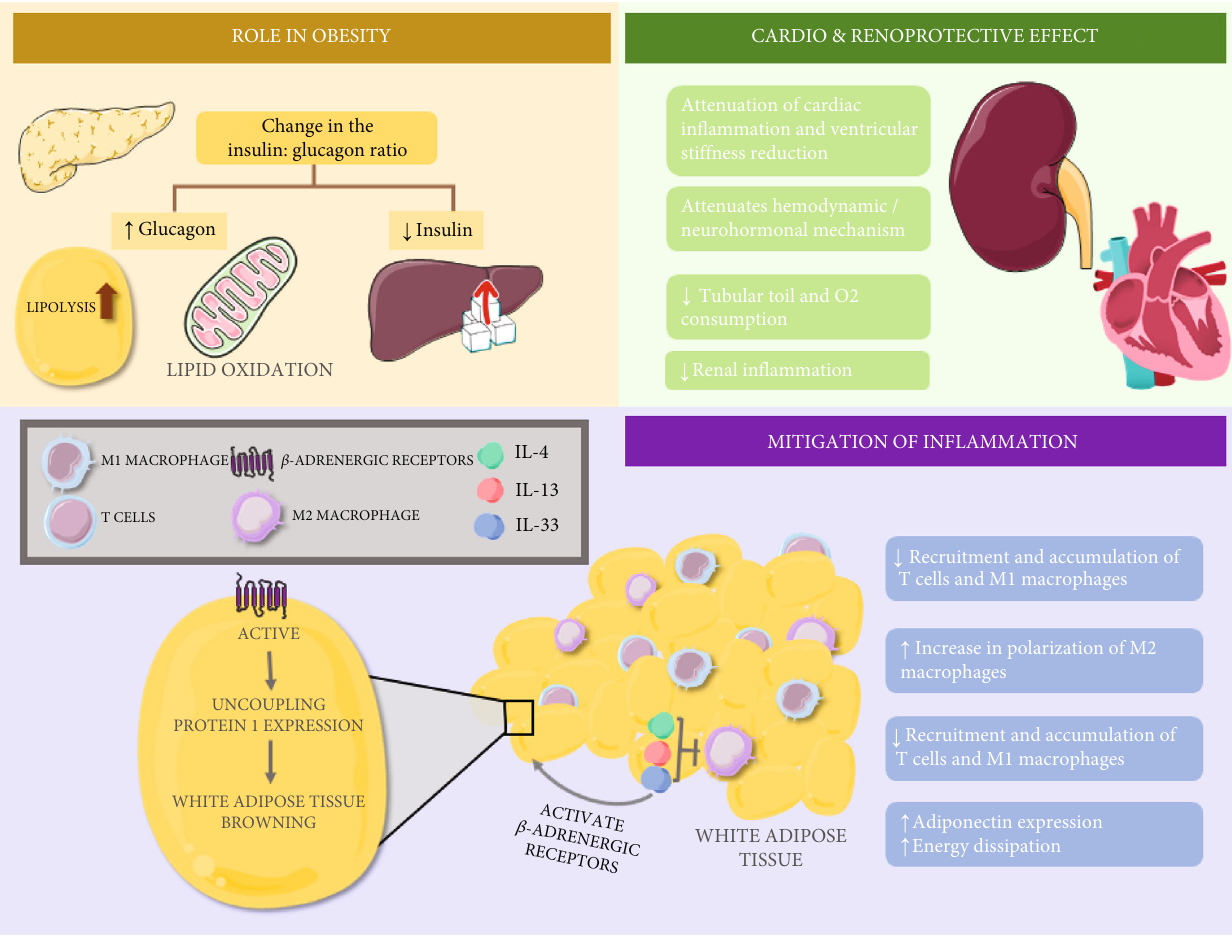
Figure 2: Role of SGLT2i in obesity, adipose tissue in fl ammation, and cardiac and kidney disease. In obesity, these drugs modify the insulin :glucagon ratio, where glucagon increases, favoring lipolysis and lipid oxidation, while insulin decreases, causing an increase in endogenous glucose production from amino acids, favoring the process of lipolysis even more. Also, they attenuate the hemodynamic/neurohormonal mechanism in the kidney with positive changes of glomerular fi ltration rate (GFR), the tubular transport toil, and oxygen consumption. Ultimately, they have a role in the mitigation of in fl ammation decreasing the recruitment and accumulation of T cells and M1 macrophages, increasing the polarization of M2 macrophages, which release anti-in fl ammatory cytokines while activating adrenergic receptors in adipocytes, producing thermogenesis by the expression of uncoupling protein (UCP1). Furthermore, they increase adiponectin expression, which promotes the downregulation of SGLT2 and subcutaneous white adipose tissue (WAT) browning by stimulating the proliferation of M2 macrophages. SGLT2i: sodium-glucose cotransporter 2 inhibitors; GFR: glomerular fi ltration rate; UCP: uncoupling proteins; WAT: white adipose